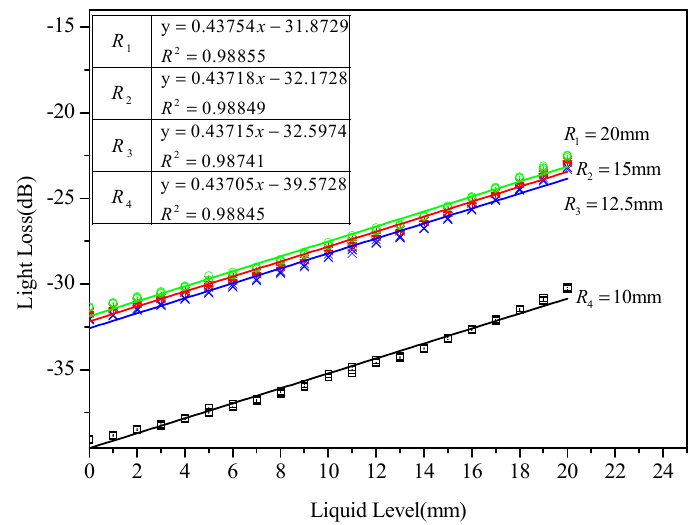
Figure 9. POFS performance test with different bending radii.